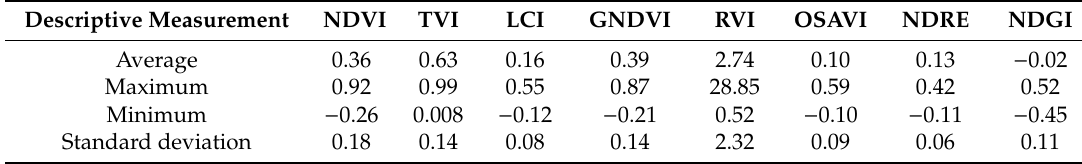
Table 5. Descriptive statistics of vegetation indices in Pinus arizonica Engelm. clonal orchard.